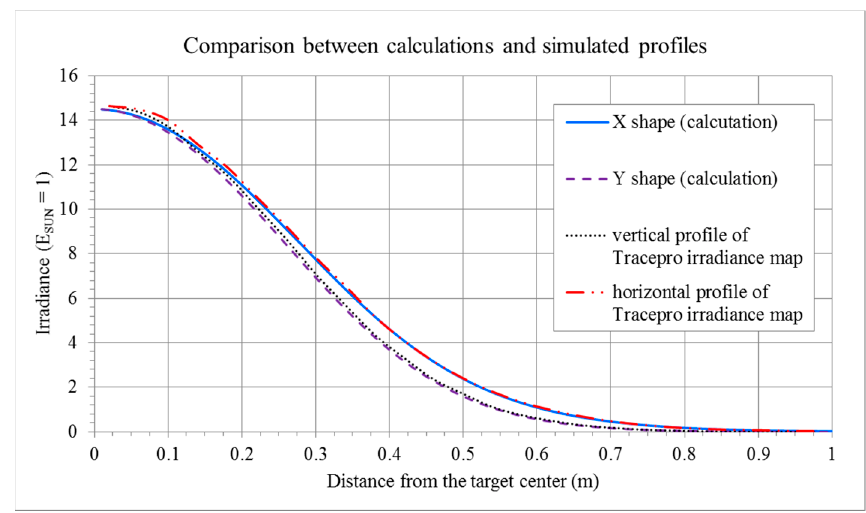
Figure 15. Comparison between simulated irradiance profiles and calculated shapes for a 5 × 5 heliostat field with row dist. 4 m and column dist. 10 m.